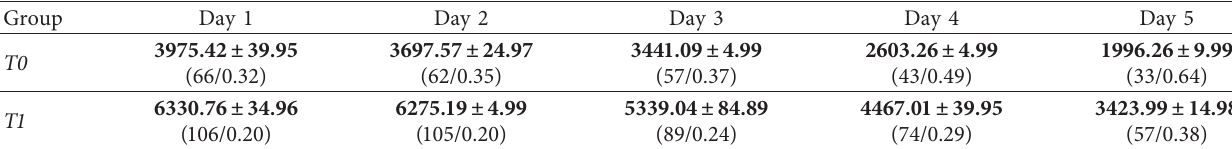
Table 5: The number of motile sperm per ejaculate, average number of doses, and volume (mL) per dose for intracervical insemination using Kacang goat semen stored at 5 ° C for five days in skim milk-egg yolk extender with and without the addition of 150kDa protein isolated from Simmental bull seminal plasma. 5 ° C for five